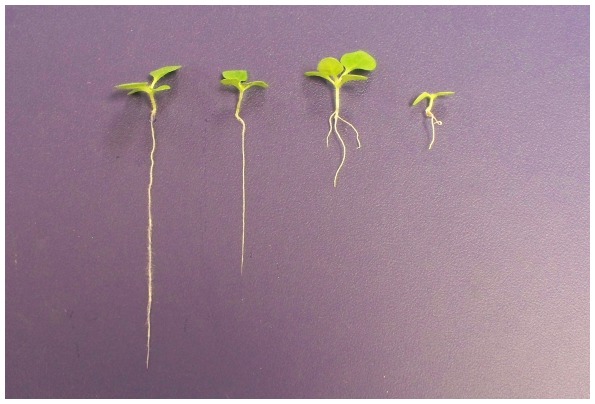
Phenotype of aluminum oxide treated tobacco seedlings.From left to right, control, 0.1%, 0.5%, and 1% aluminum oxide treated seedlings.